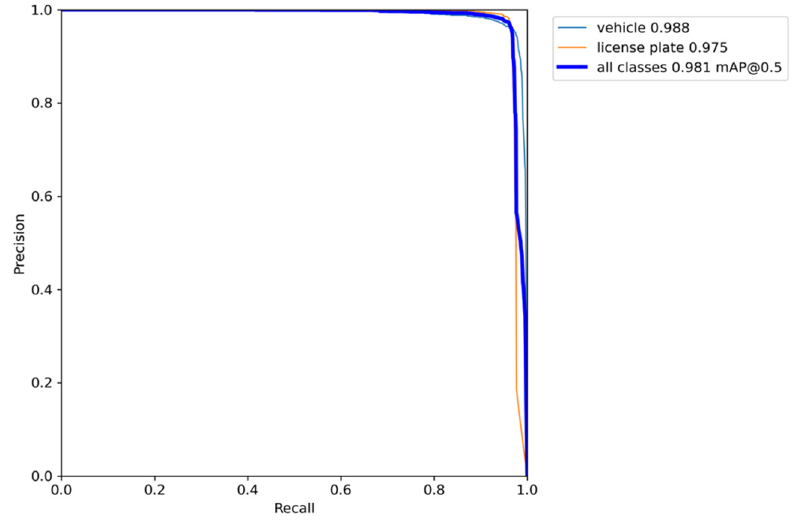
Figure 8. The precision–recall curve of the detection results.